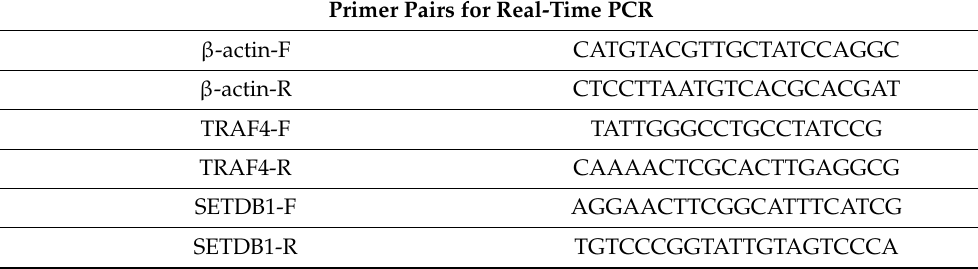
Table 1. Primer pairs for real-time